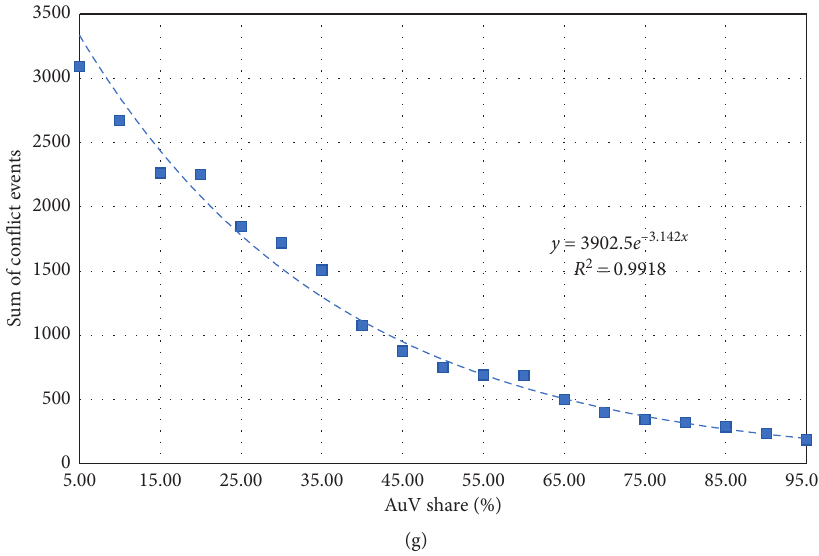
Figure 5: Counts of detected conflict events at (a) base case (0%), (b) 5%, (c) 25%, (d) 50%, (e) 75%, and (f) 95% AuV share, and (g) pattern of total detected conflict events at increasing AuV